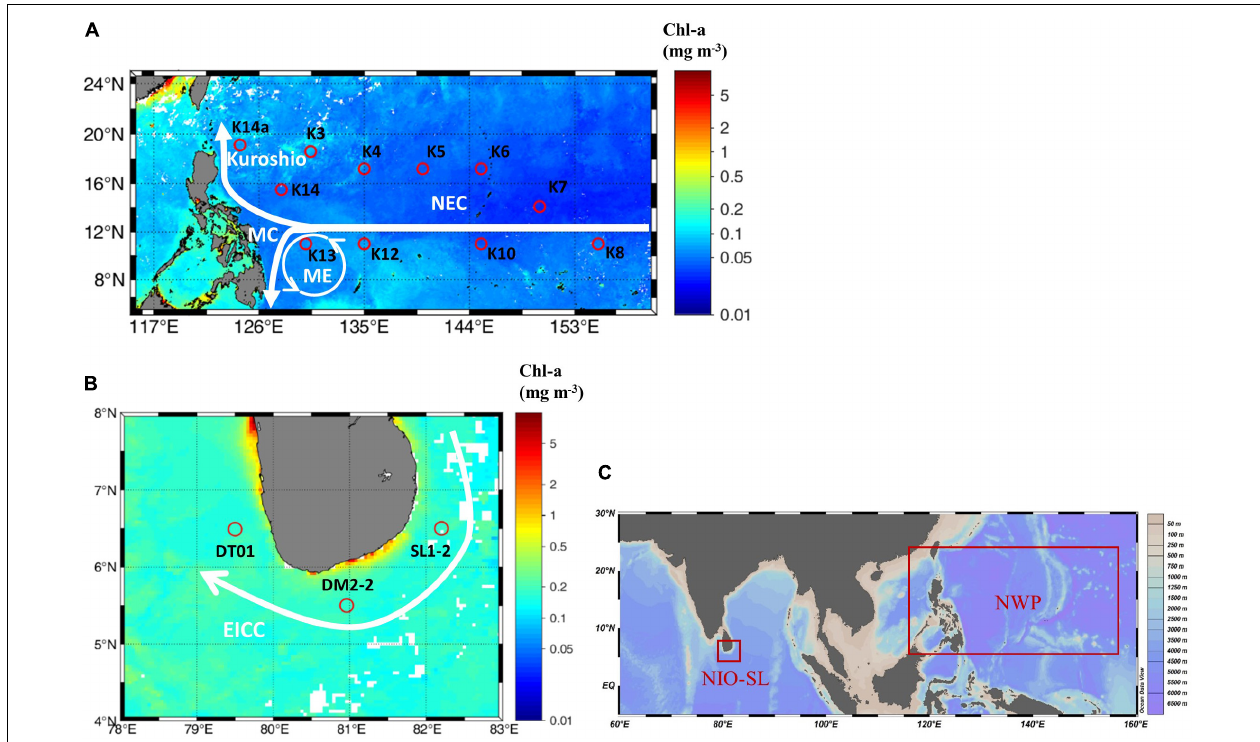
FIGURE 1 | (A) Sampling stations during the GEOTRACES cruise GP09 performed onboard the R/V Tan Kah Kee during the spring (April 25–June 13, 2019) in the Northwest Pacific (NWP), and (B) during an international joint cruise of the R/V Xiangyanghong-6 during January 2020 in the North Indian Ocean in the vicinity of Sri Lanka (NIO-SL). Main currents are also shown, which include Kuroshio, North Equatorial Current (NEC), Mindanao Current (MC), and Mindanao Eddy (ME) in the NWP (Liu et al., 2017) as well as East Indian Coast Current (EICC) in the NIO-SL (Vos et al., 2014). (C) Global locations of two study regions. The figure’s background is Moderate Resolution Imaging Spectroradiometer (MODIS) monthly Level 3 Chl-a data which were downloaded from NASA’s ocean color website (http://oceandata.sci.gsfc.nasa.gov).